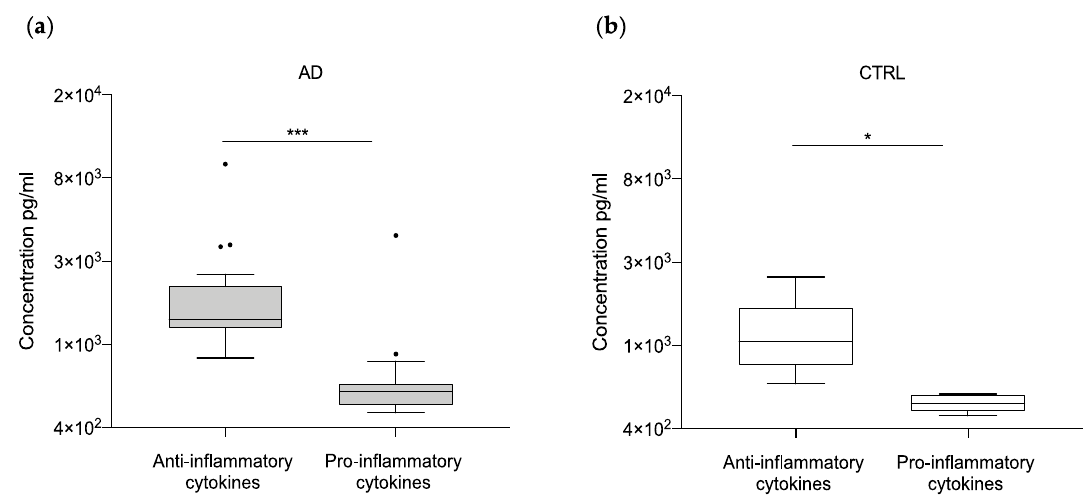
Figure 4. Comparison between pro- and anti-inflammatory cytokines in AD and control samples. Boxplot of the pro-inflammatory (IFN- γ , IL-1 α , IL-2, IL-6, IL-12 p70, IL-18) and the anti-inflammatory (IL-1rn, IL-4, IL-13) cytokines are shown for AD ( p -value < 0.0001) ( a ) and control ( p -value 0.29) ( b ) group. * p < 0.05, *** p < 0.001. Dots indicate outlier values. Natural logarithm scale has been used for a better graphical representation. Table 1. The median ( µ 1/2) and the rate of measurements (pg/mL) for the detectable analytes in AD versus control. Values in bold underline the statistically significant differences between the